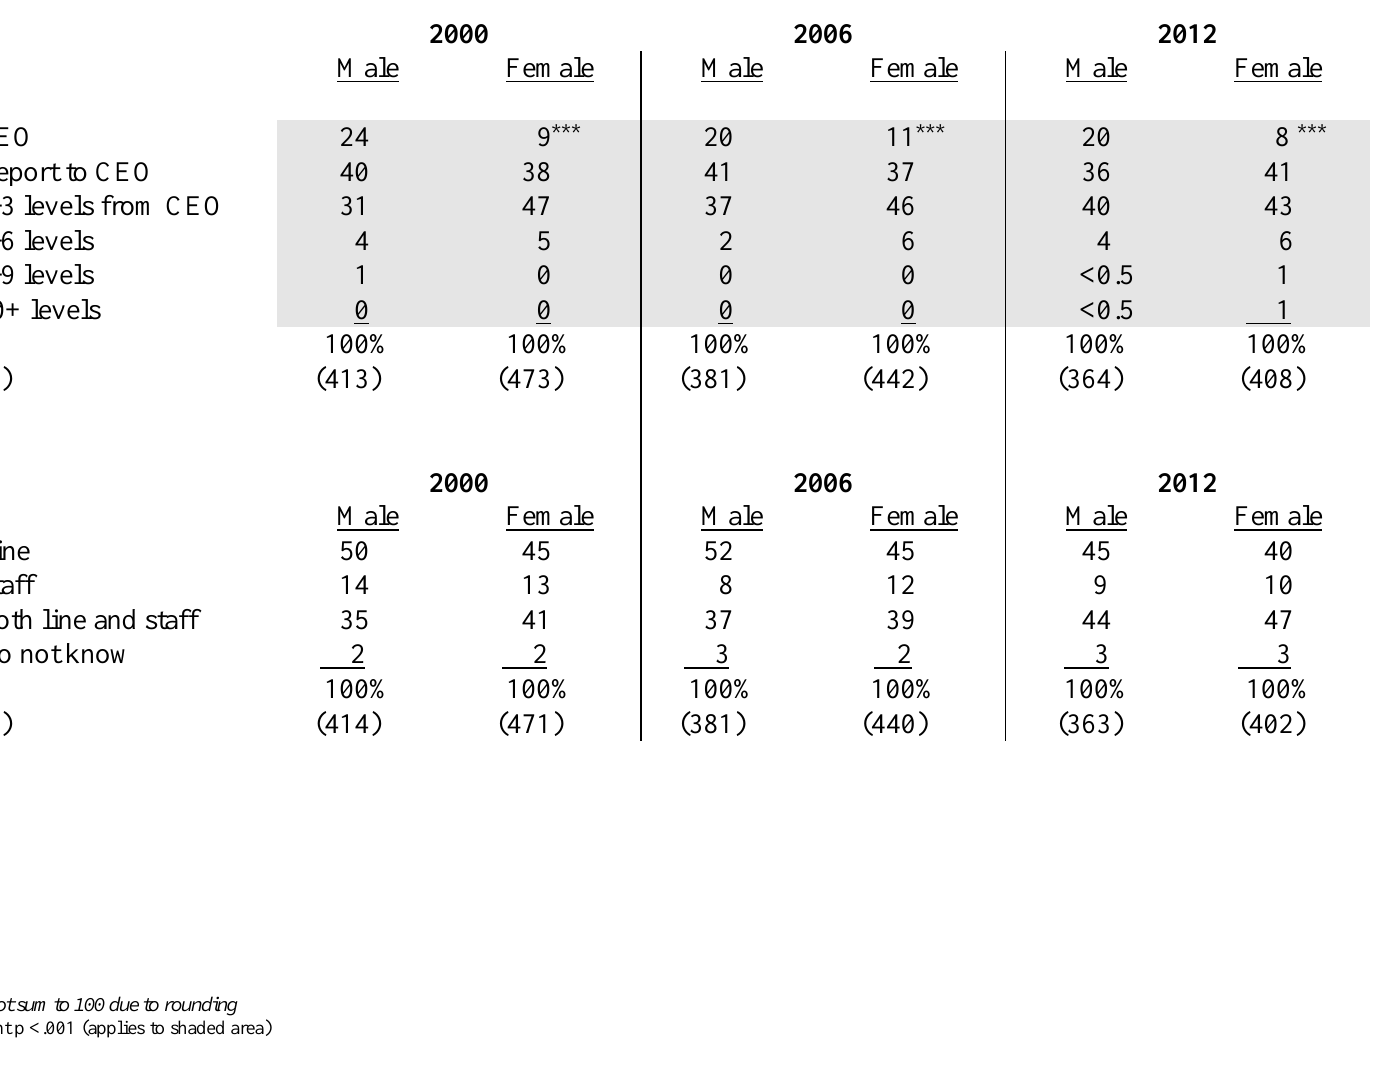
Table 3. Reporting Level by Gender